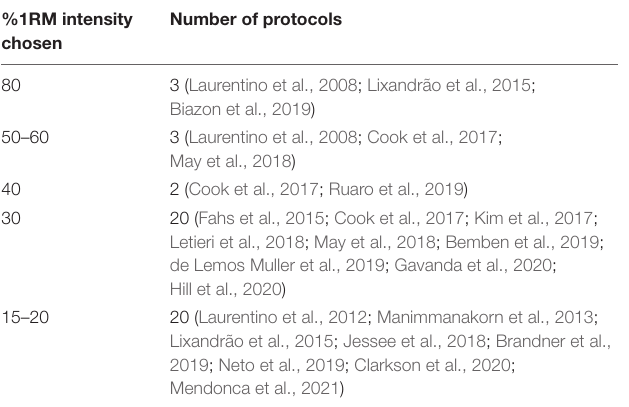
TABLE 3 | Distribution of exercise choice/muscle group tested across the 48 protocols. Exercise choice Number of protocols